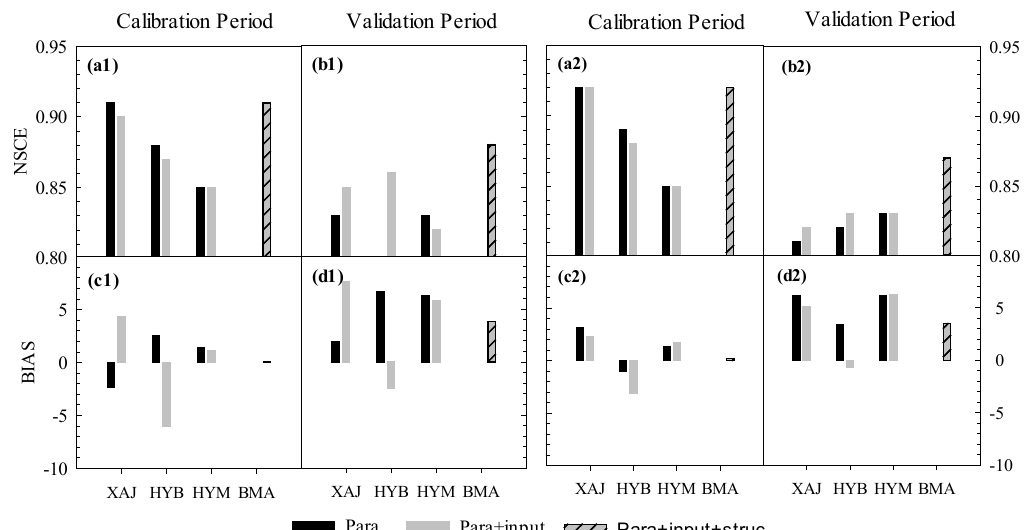
Fig. 2 The precision performances of the SCE-UA (left) and SCEM-UA (right) based streamflow simulation at different simulation